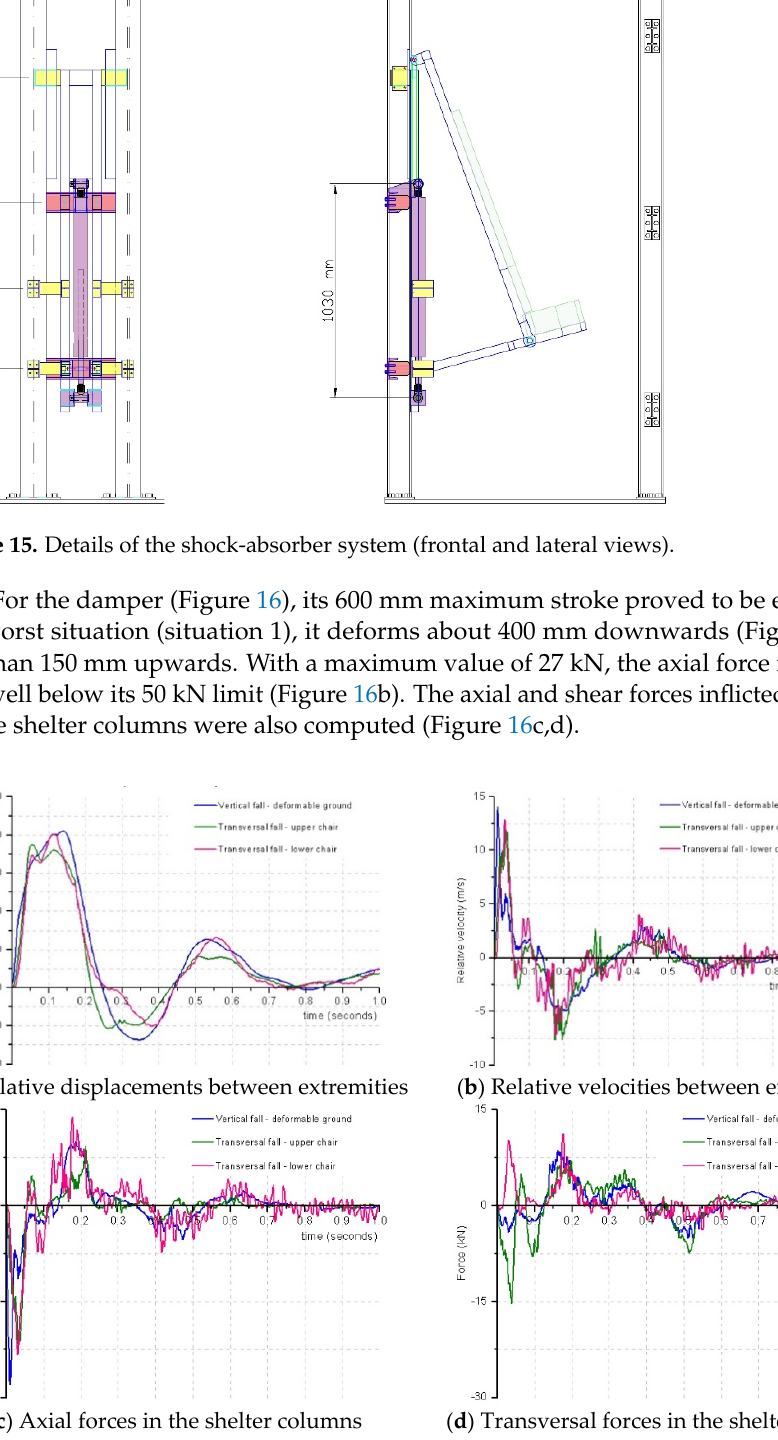
Figure 16. Damper results (situation 1 to situation